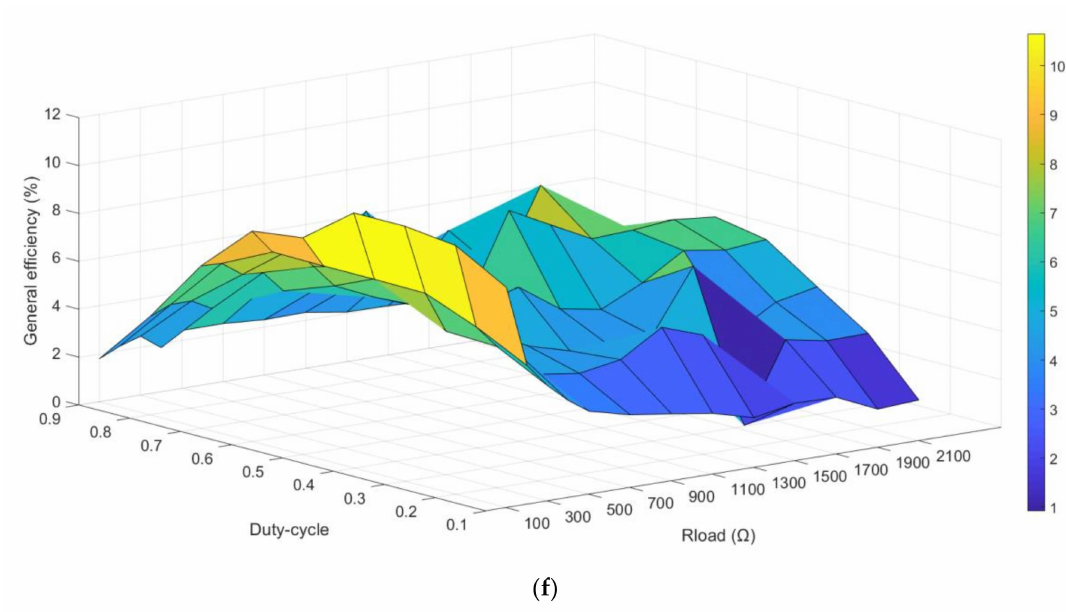
Figure 33. Split N converter simulation results. The ( a , c , e ) figures are with 3 m / s wind velocity and 333 kHz switching frequency. The ( b , d , f ) figures are with 10 m / s wind velocity and 500 kHz switching frequency. ( a ) Output power (3 m / s, 333 kHz). ( b ) Output power (10 m / s; 500 kHz). ( c ) Output voltage (3 m / s, 333 kHz), Red plane: 3 V as minimum. ( d ) Output voltage (10 m / s, 500 kHz), Red plane: 3 V as minimum. ( e ) Generator + Converter e ffi ciency (3 m / s, 333 kHz). ( f ) Generator + Converter e ffi ciency (10 m / s; 500